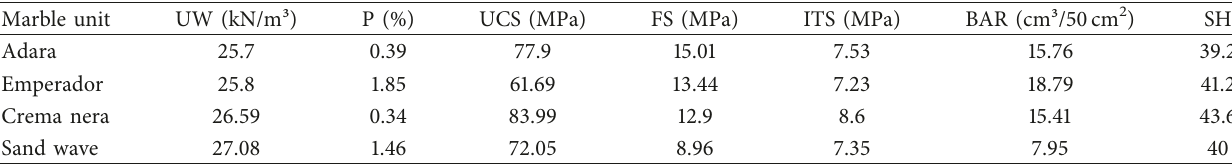
Figure 2: Measurement of (a) surface roughness and (b) Table 1: Results of physicomechanical tests.